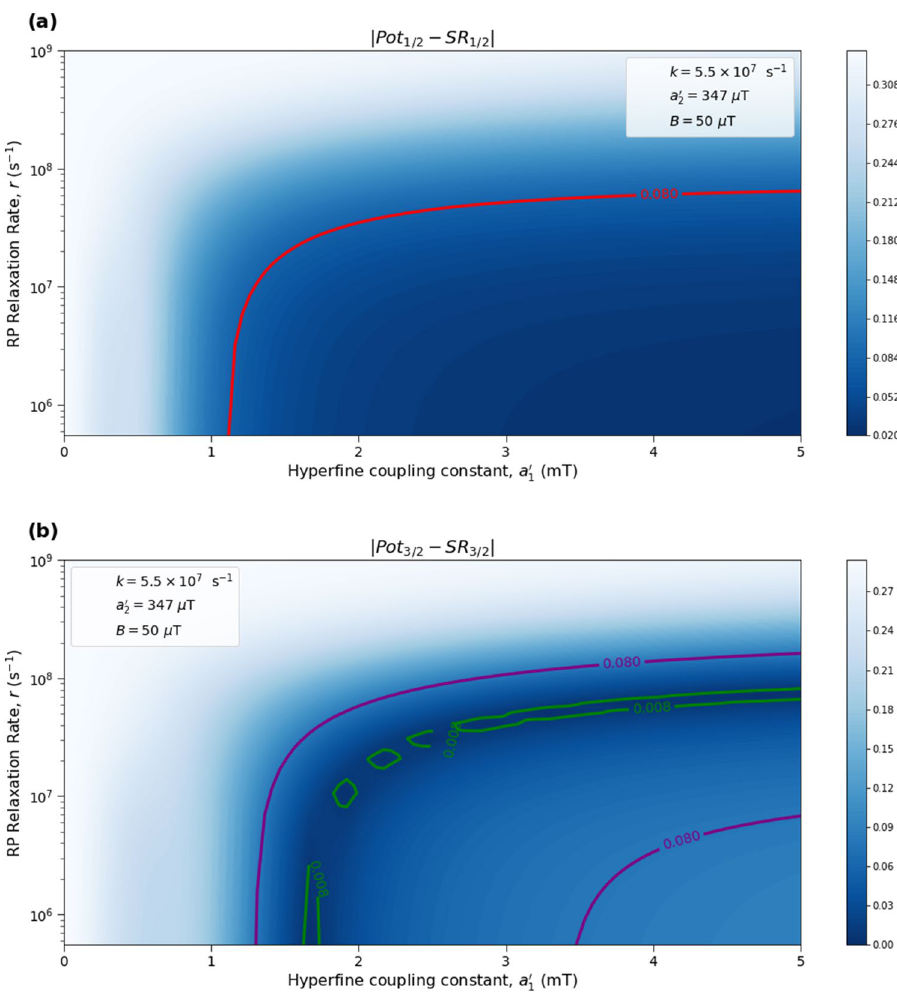
Figure 2. The dependence of the agreement between relative anesthetic potency and singlet yield ratio on changes in the hyperfine coupling constant a ′ 1 and the RP spin-coherence relaxation rate r for a ′ 1 ∈ [ 0, 5000 ] µ T and r ∈ [ 5.0 × 10 5 , 1.0 × 10 9 ] s − 1 , using a ′ 2 = 347 µ T, B = 50 µ T, and k = 5.5 × 10 7 s − 1 . The singlet yield ratio SR is calculated using a 1 = (γ n / | γ 129 Xe | )γ e a ′ 1 , where the magnitude of the isotopic nuclear gyromagnetic correction factor, (γ n / | γ 129 Xe | ) , is normalized for 129 Xe. The model can explain the experimentally derived 6 relative anesthetic potency of xenon for values of a ′ 1 and r where | Pot 1 / 2 − SR 1 / 2 | , | Pot 3 / 2 − SR 3 / 2 | ≤ 0.08 . (a) The absolute difference between Pot 1 / 2 and SR 1 / 2 . (b) The absolute difference between Pot 3 / 2 and SR 3 / 2